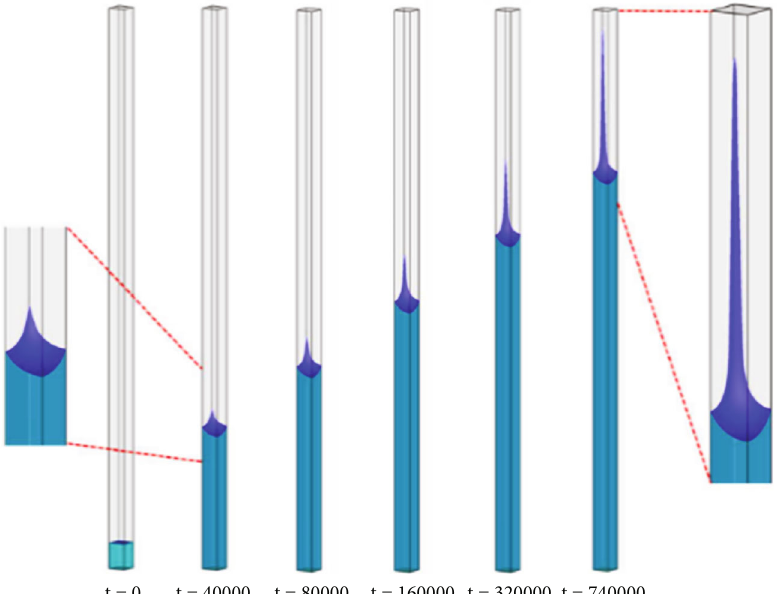
t = 0 Figure 10: LBM simulation of wet phase liquid distribution in the regular square tube with di ff erent time steps